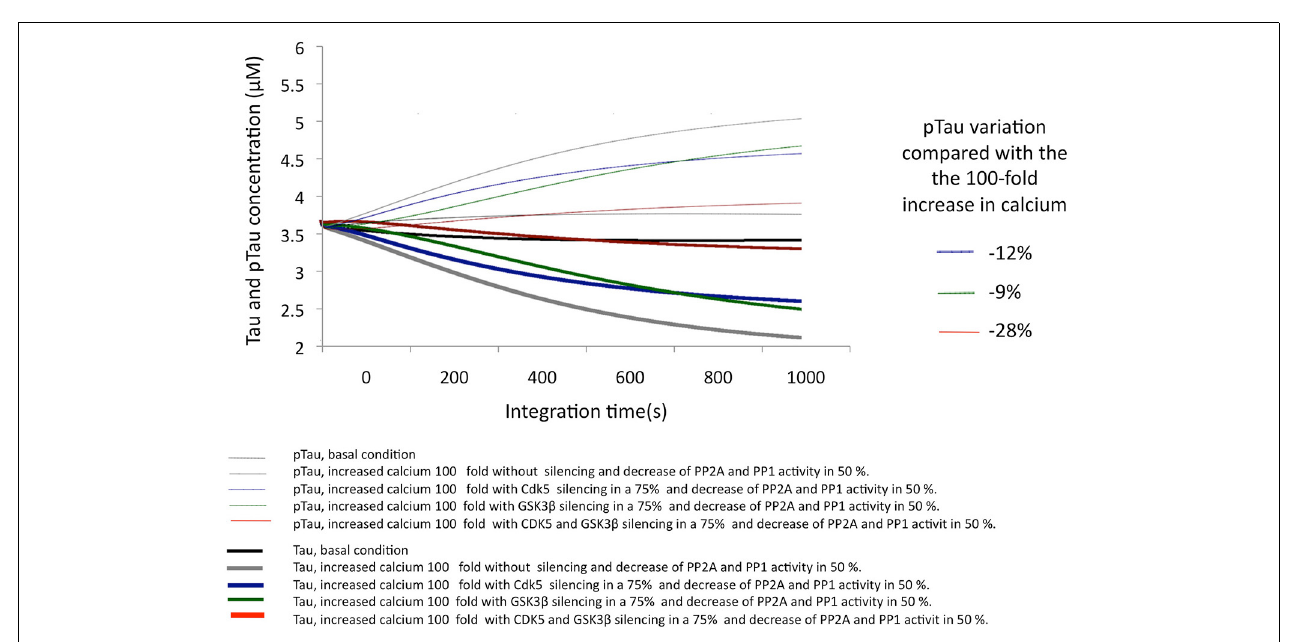
FIGURE 6 | Changes in the levels of Tau and pTau in response to SIS of CDK5 and GSK3 β in conditions simulating AD with increased calcium levels and a decrease in phosphatase